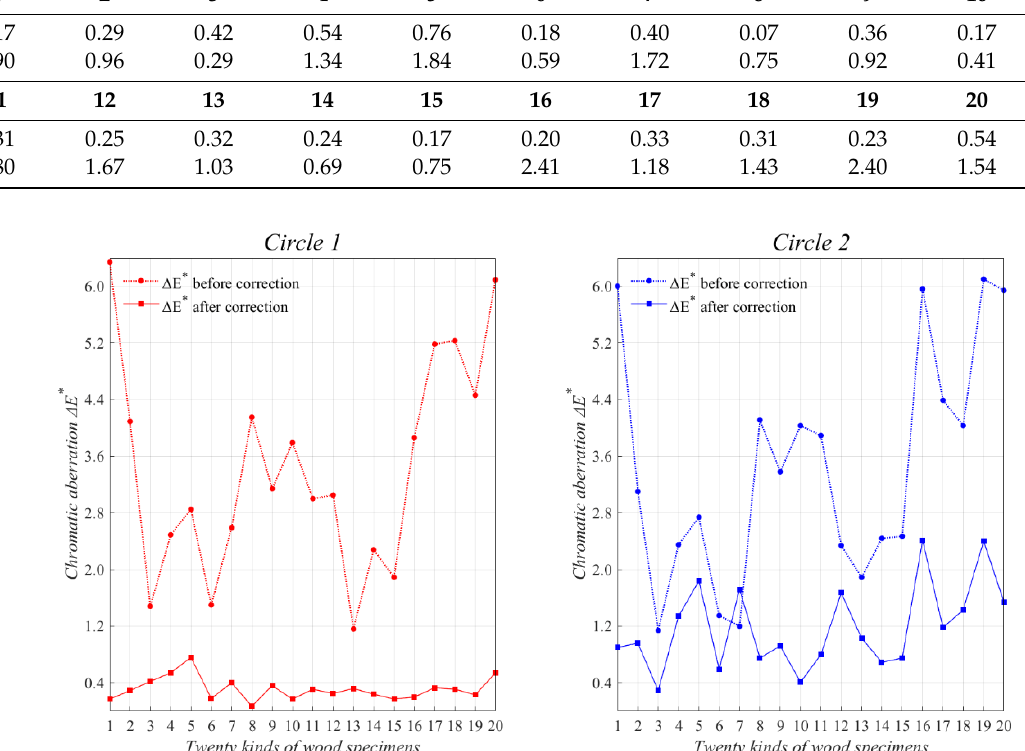
Figure 5. Changing trends of ∆ E ∗ before and after the chromatic aberration